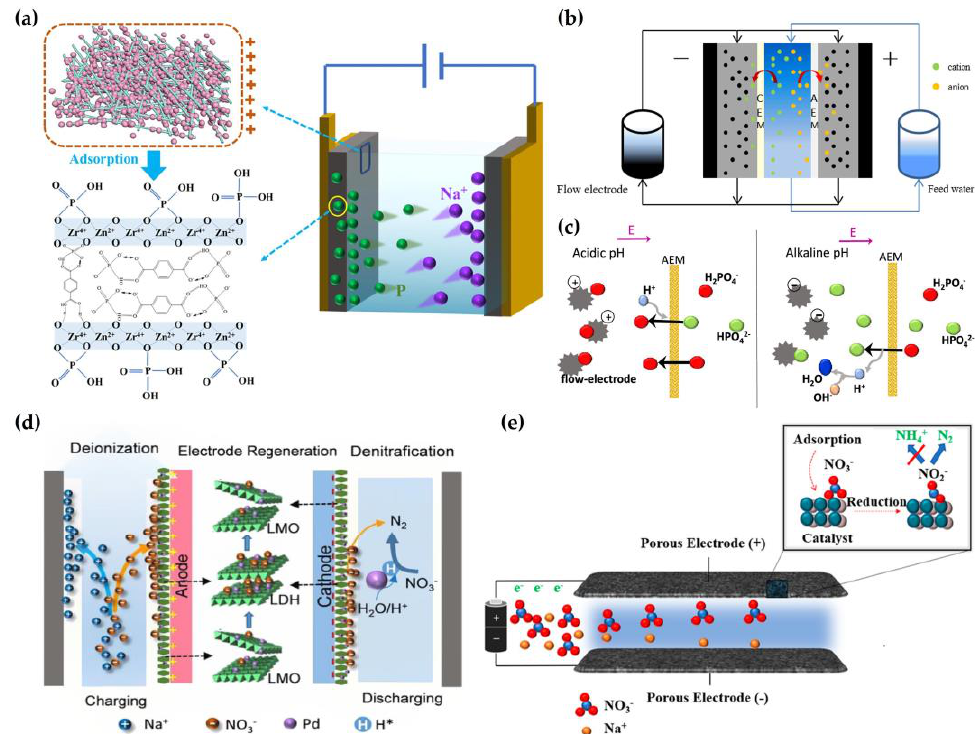
Figure 7. ( a ) Mechanism diagram of phosphate adsorption by ZnZr-COOH/CNT electrode